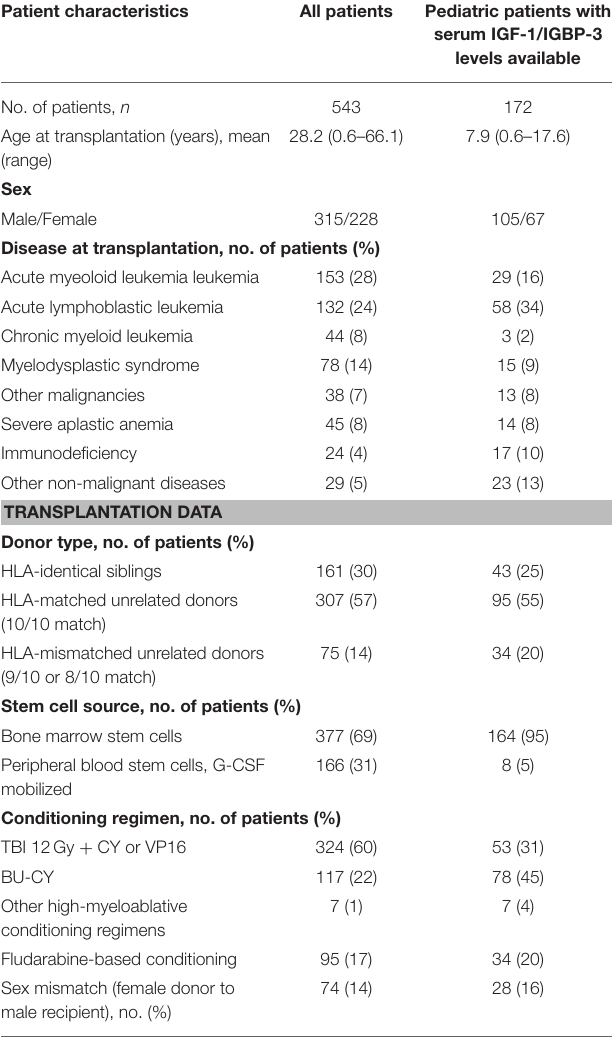
TABLE 1 | Patient characteristics and transplantation